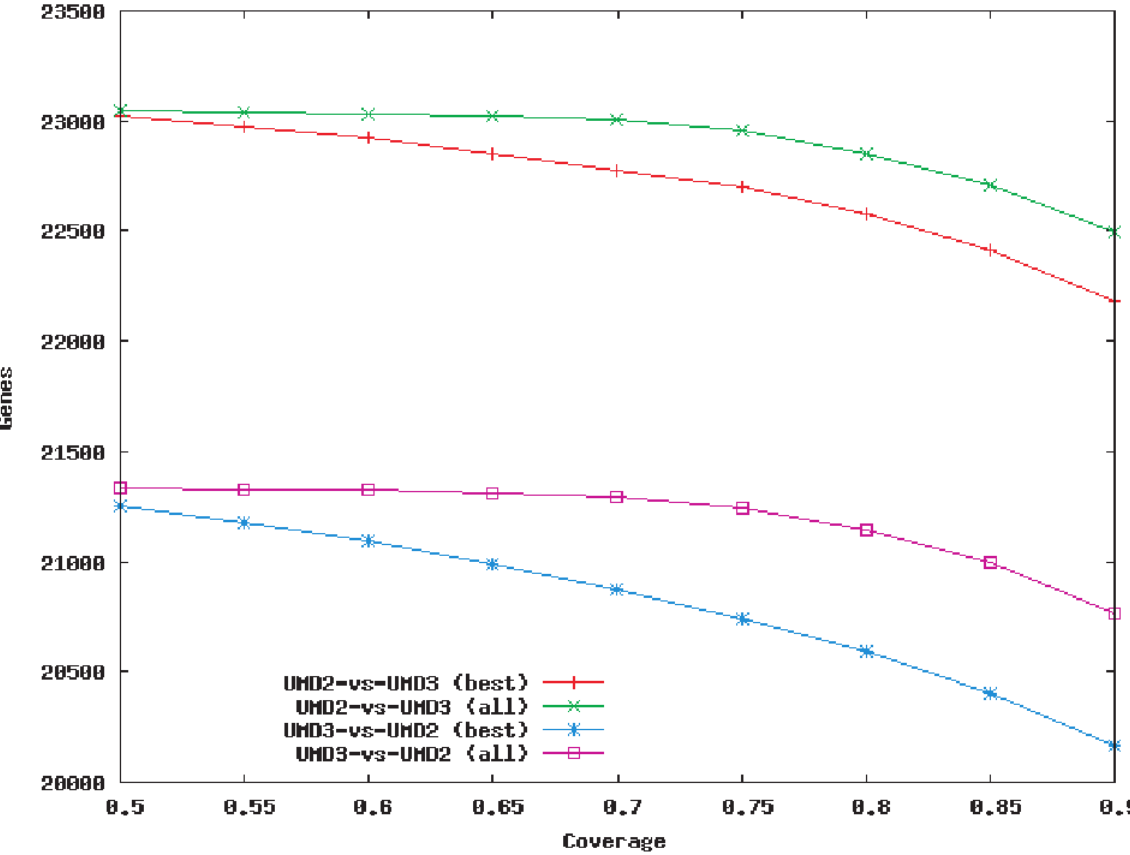
Figure 1. Mapping rates of annotated gene sequences between the UMD2 and UMD3 assemblies. Plotted values represent the numbers of genes in one annotation that have coverage x or larger in the other genome, where coverage refers to the proportion of the transcript covered. All: all alignments of a transcript are used to compute coverage; best: only the best alignment is used. For example, the red line shows that just over 23,000 genes from UMD2 have at least 50% of their sequence (coverage 0.5) aligned to a corresponding gene in UMD3. The total number of annotated protein-coding genes is 23,221 for UMD2, and 21,342 for UMD3.